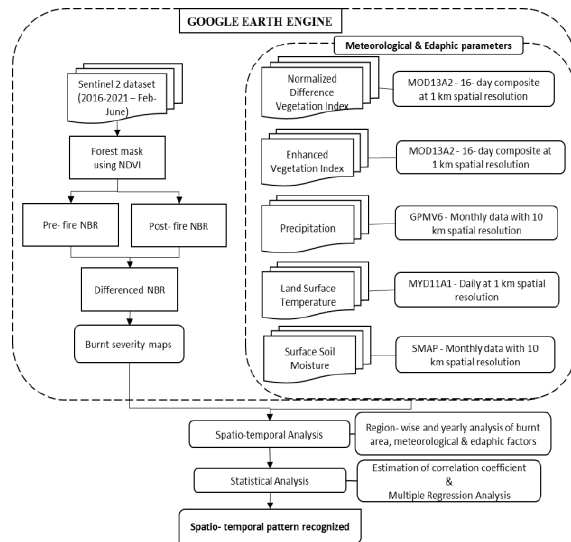
Figure 2. Methodology flow chart for the